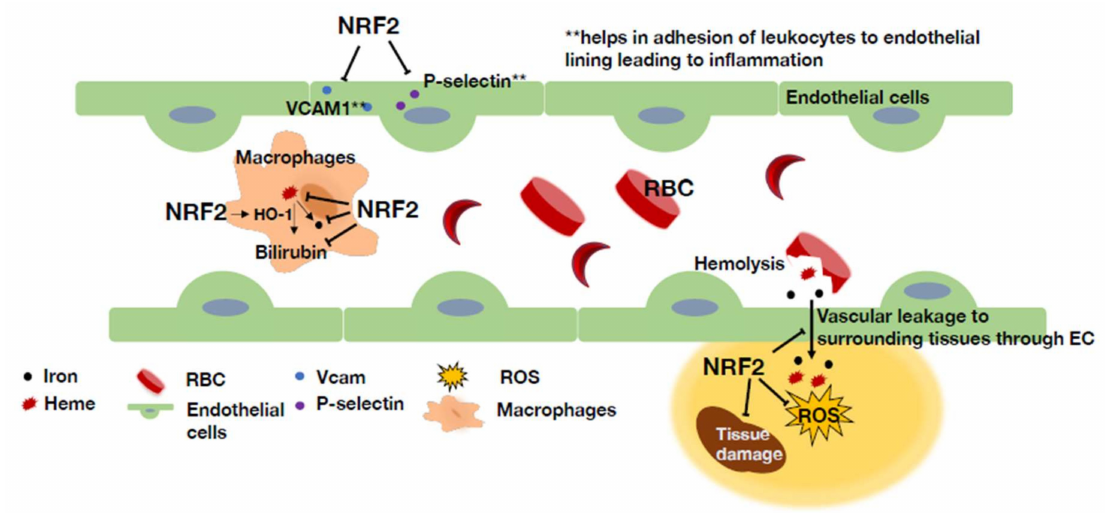
Figure 8. NRF2 plays multifarious roles in the sickle cell disease. NRF2 activation in macrophages contributes to increased HO-1 levels. This increase in HO-1 leads to the breakdown of hemolysis- induced release of free heme into less toxic byproducts. Increased NRF2 levels in endothelial cells help maintain vascular integrity and prevent vascular leakage into surrounding tissues. In addition, P-selectin and VCAM1 levels are also regulated by NRF2 in endothelial cells. This change in P- selectin and VCAM1 levels reduces the adhesion of leukocytes to the endothelial lining, decreasing inflammation and